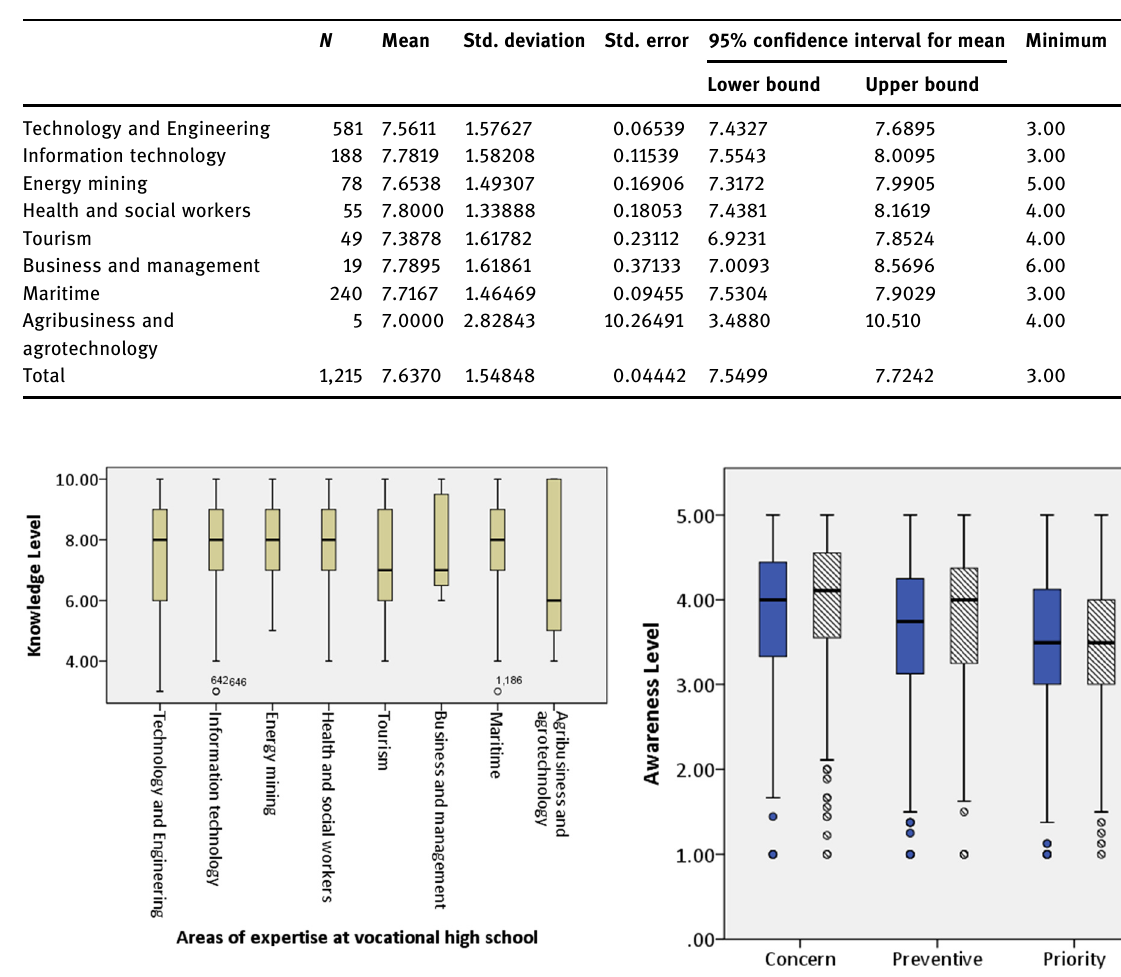
Figure 8: Student ’ s knowledge level by areas of expertise at VHS.